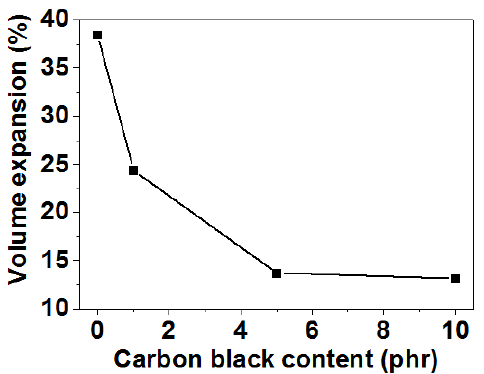
Figure 7. The porosity of carbon blocks according to the added CB amount. Figure 6. The volume expansion of carbon blocks according to the added CB amount.